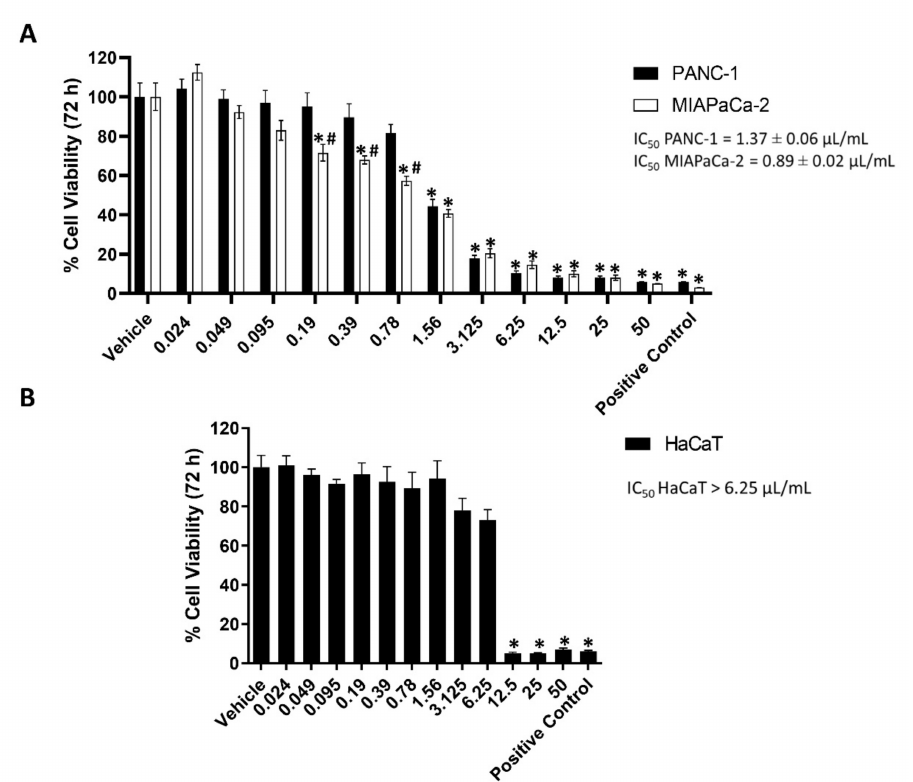
Figure 1. ( A ) PANC-1 and MIAPaCa-2 cell viability after treatment with different concentrations of EPO ( µ L/mL) for 72 h. Vehicle (dimethyl sulfoxide (DMSO)) was used as negative control and paclitaxel (PTX) 23.9 µ g/mL as positive control. Data shown are expressed as mean ± SD of three separate experiments. * p < 0.05 treated PANC-1 or MIAPaCa-2 vs. vehicle, # p < 0.05 treated PANC-1 vs. treated MIAPaCa-2. ( B ) HaCaT cell viability after treatment with different concentrations of EPO ( µ L/mL) for 72 h. Vehicle (DMSO) was used as negative control and 23.9 µ g/mL PTX as positive control. Data shown are expressed as mean ± SD of three separate experiments. * p < 0.05 treated HaCaT vs. vehicle.